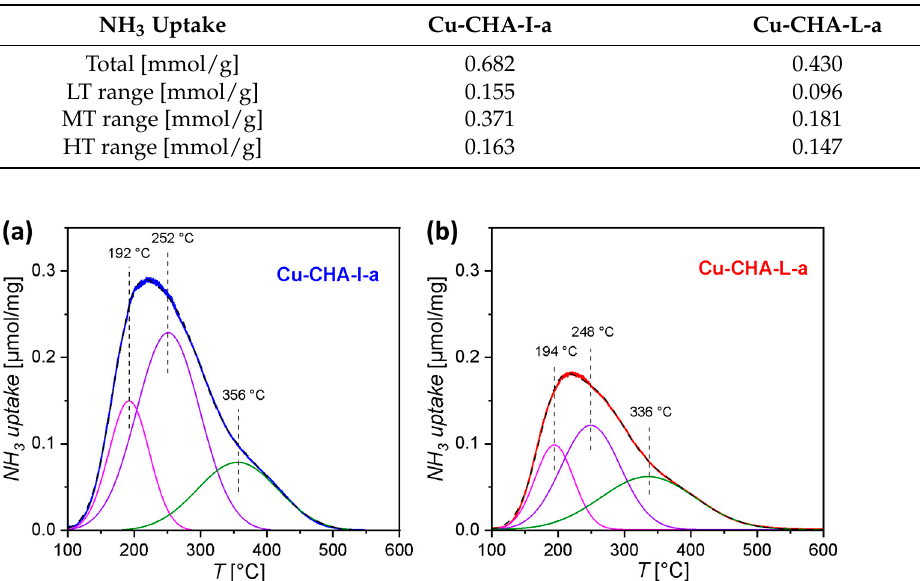
Table 2. NH 3 uptake derived by deconvolution of the NH 3 -TPD profile in the low, mid and high temperature ranges (LT, MT and HT, respectively). Figure 3. Deconvoluted NH 3 -TPD profiles of ( a ) Cu-CHA-I-a and ( b ) Cu